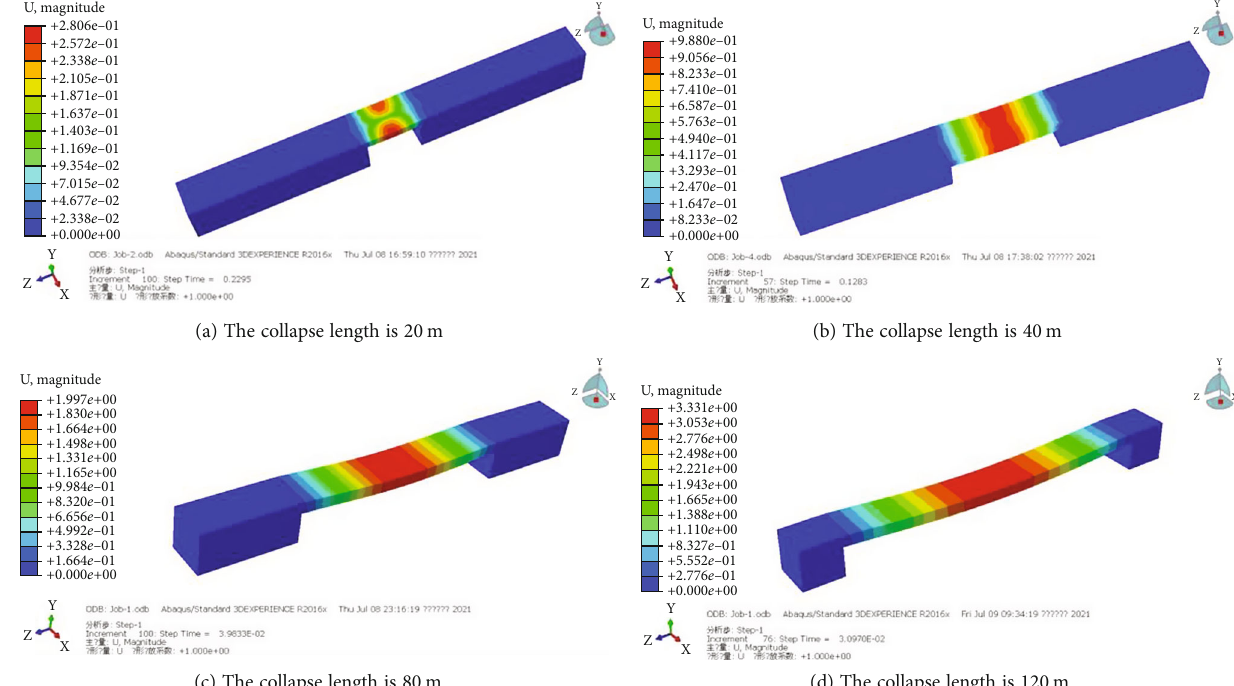
Figure 4: Soil displacement under di ff erent collapse